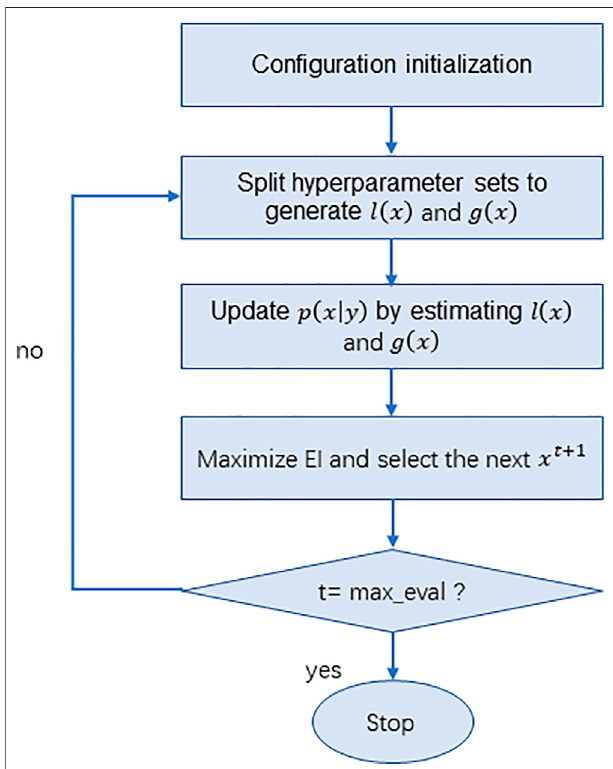
FIGURE 2 | Flowchart of the TPE